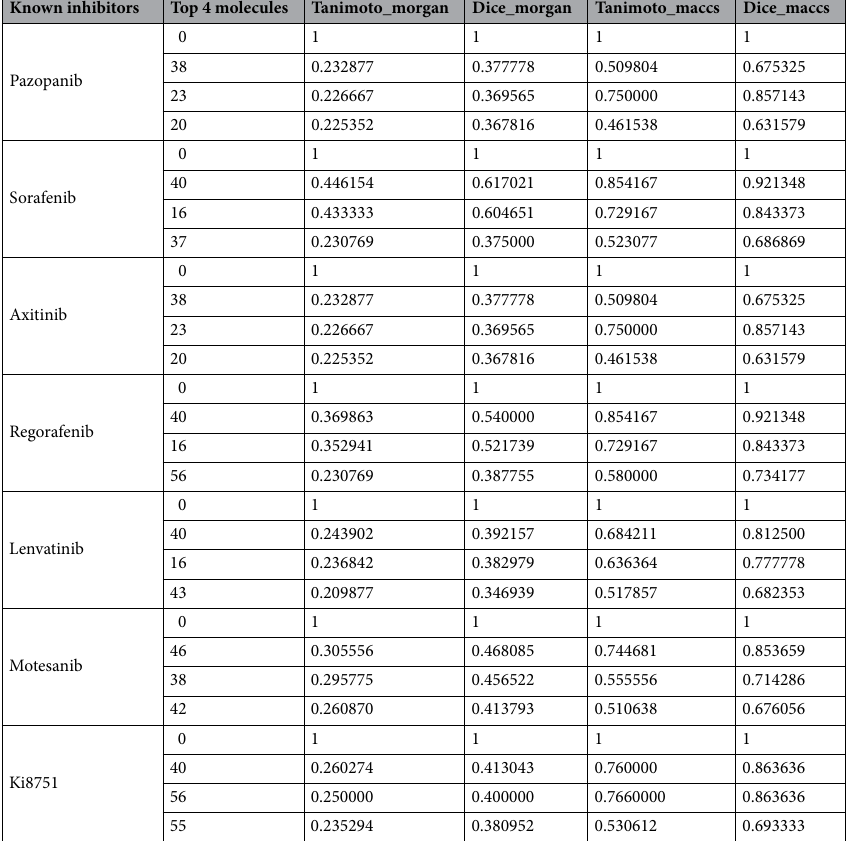
Table 3. Similarity checking between Pazopanib, Sorafenib, Axitinib, Regorafenib, Lenvatinib, Motesanib, and Ki8751 with top-ranked molecules using the Morgan2 and MACCS fingerprints. (Compound 0 is the reference in each